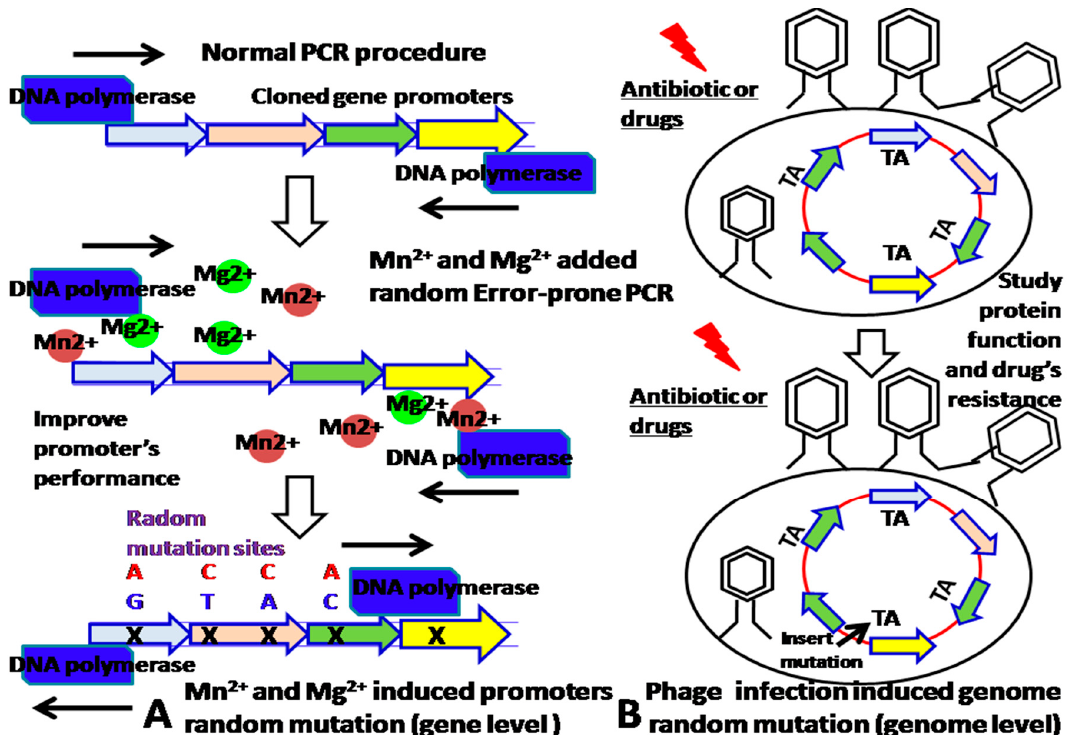
Figure 2. ( A ). Mn 2+ - and Mg 2+ -added random, error-prone PCR approach introduces the gene mutation sites at the gene level. ( B ) Phage infection introduces random genome mutation sites.